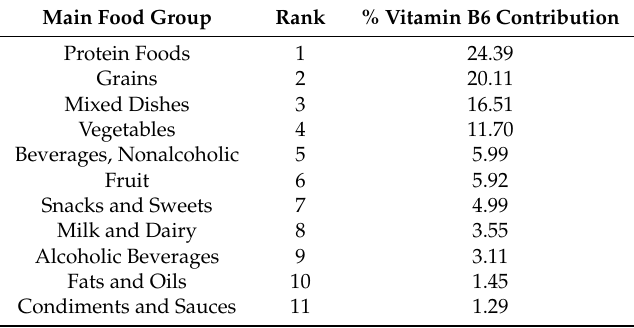
Table 20. Food sources of vitamin B6 contribution in the total U.S. diet, adults ≥ 51 years old ( n = 4522; gender combined; daily intake data; NHANES 2011–2014; main food groups contributing <1.0% not reported; data are Day 1